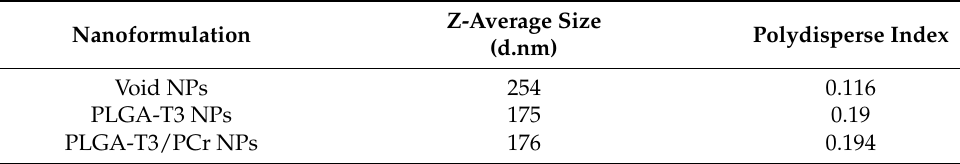
Table 1. Average particle size and pdi results of the nanoformulations.